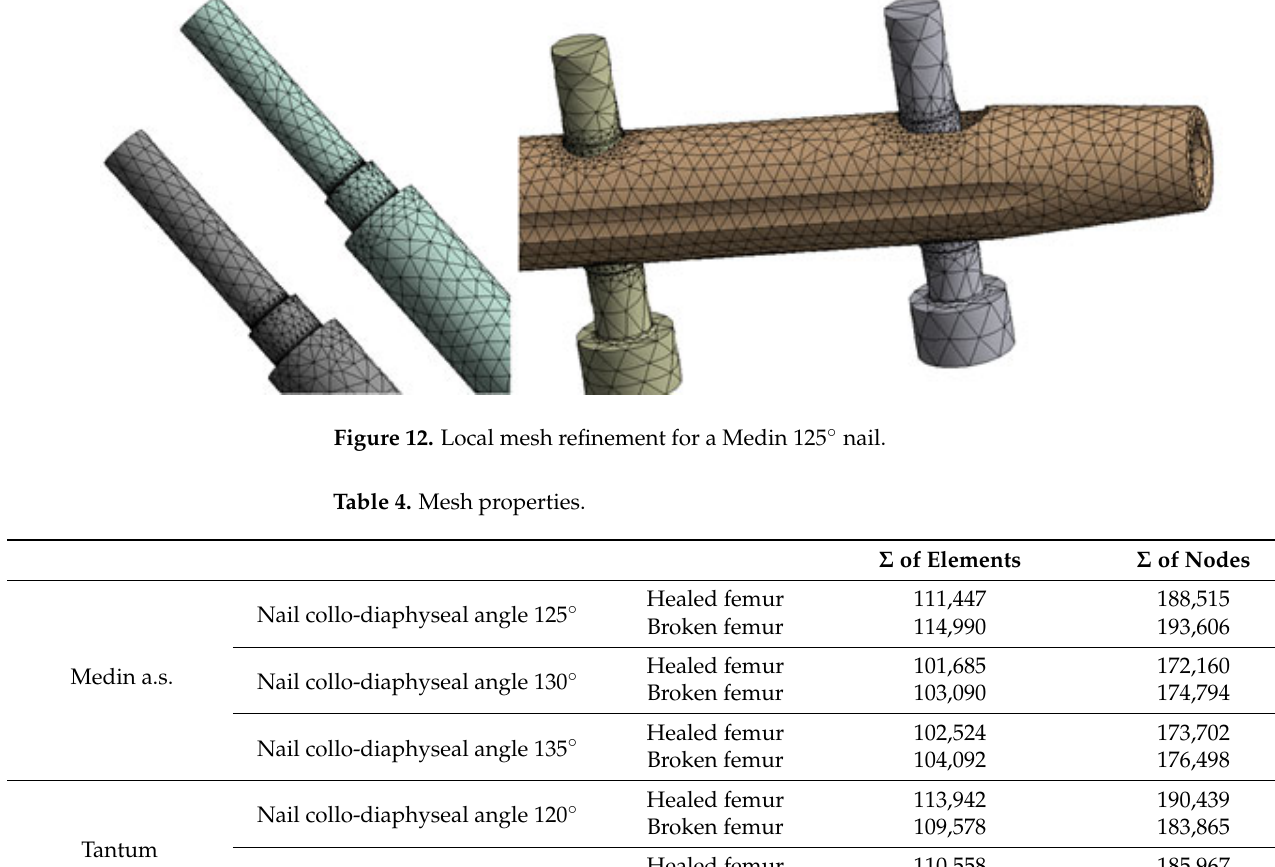
Figure 11. Finite element mesh for a Medin 125° nail.